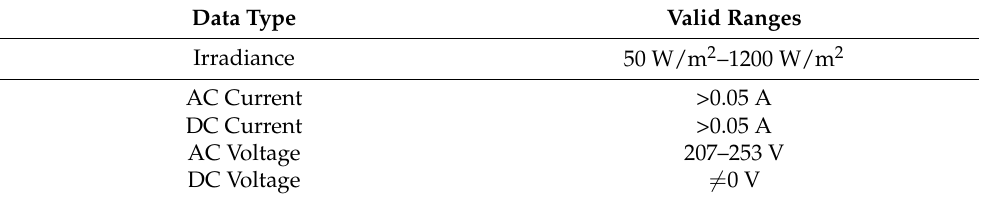
Table 1. Valid ranges defined for different types of